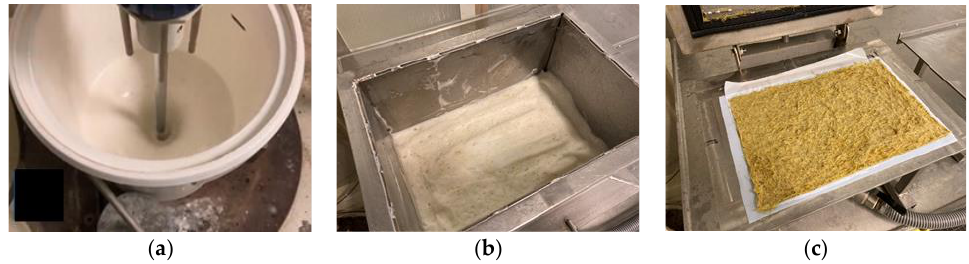
Figure 2. Laboratory sheet making: ( a ) Stirring of wet fiber foam with a foaming impeller; ( b ) foam poured in the mold; ( c ) wet sheet formed on a membrane filter after drainage. The sheet dimensions were 385 mm × 265 mm.